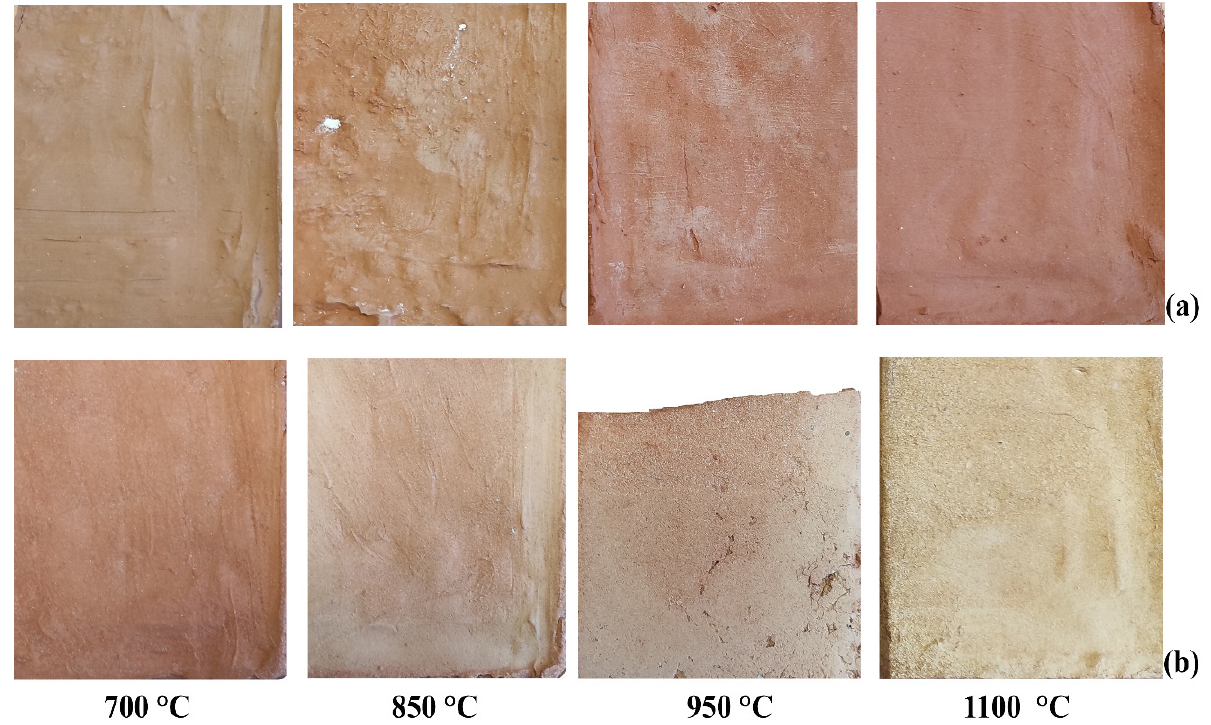
Figure 14. Experimental briquettes of DHIM01 ( a ) and DPAM01 ( b ) fired at different temperatures.